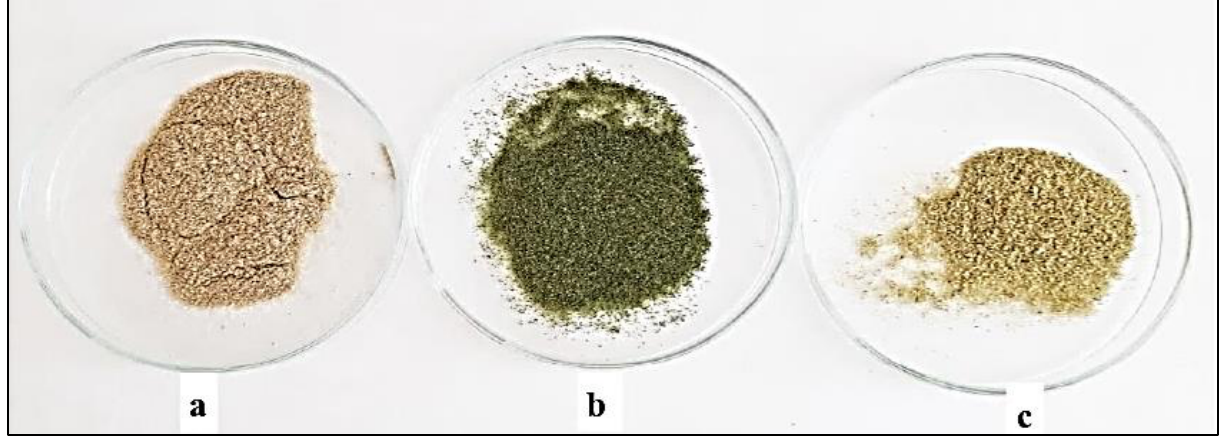
Figure 2. Powdered plant substances from stem bark ( a ), leaves ( b ) and flowers ( c ) from Ailanthus altissima. Microscopical examination of powdered stem bark substance of A. altissima. The powder is light grey (Figure 2a). Examined under a microscope using chloral hydrate solution , the powder shows the following diagnostic characters (Figure 3): fragments of brownish cork tissue in front view; fragments of phloem parenchyma with oxalate druses (10–20 µ m in diameter); isolated bundles of thick-wall fibers or fragment of fibres, usually associated in groups with sclereids; isolated or groups of sclereids, often accompanied by oxalate crystal prisms; fragments of the phloem containing large secretory schizogenous oil glands (about 50 µ m in diameter); fragments of pheloderma; isolated oxalate cluster